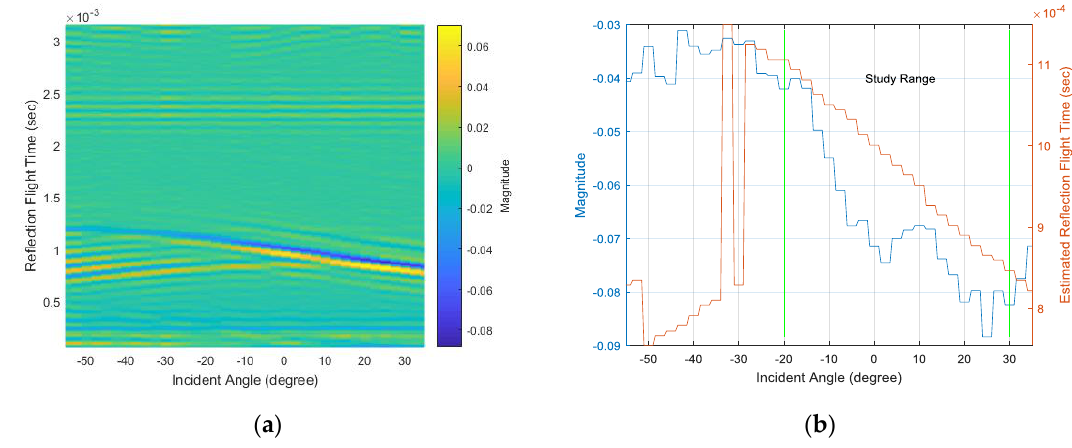
Figure 11. ( a ) Simulated SRIR with various angles at a 2.5° step and ( b ) the minimum magnitude (left y-axis) and reflection flight time (RFT) (right y-axis).